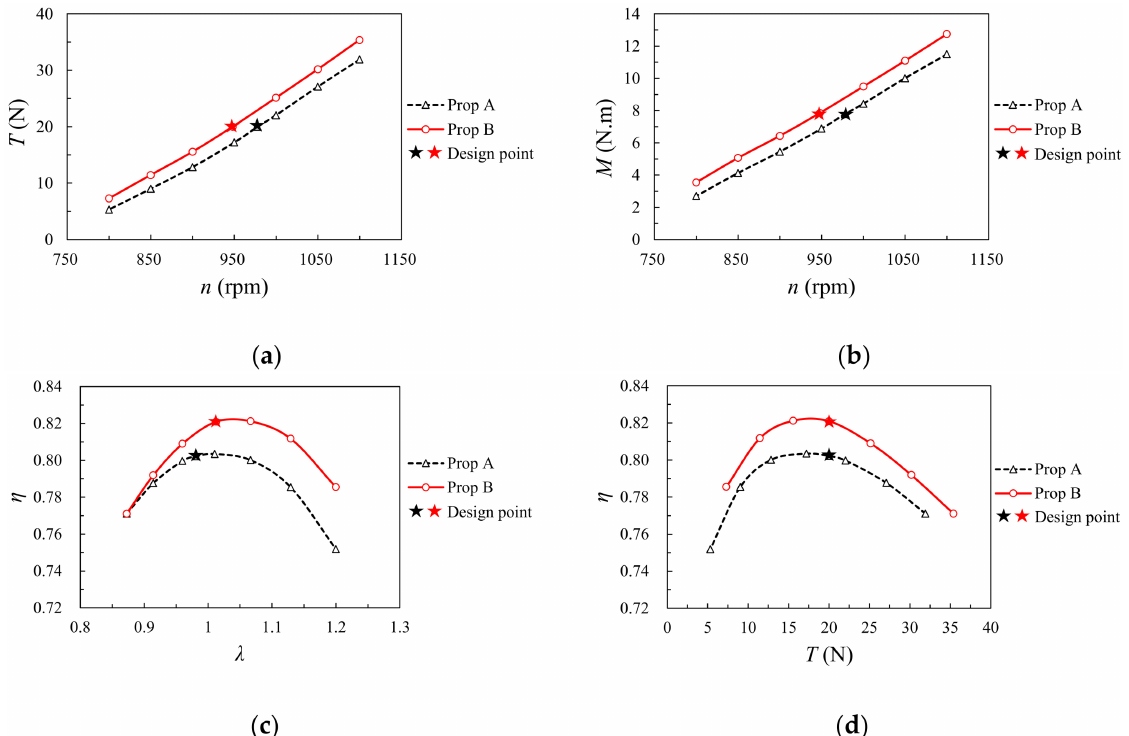
Figure 20. Aerodynamic performances of Prop A and Prop B near the design point: ( a ) Thrust vs. rotational velocity; ( b ) Torque vs. rotational velocity; ( c ) Efficiency vs. advance ratio; ( d ) Efficiency vs.